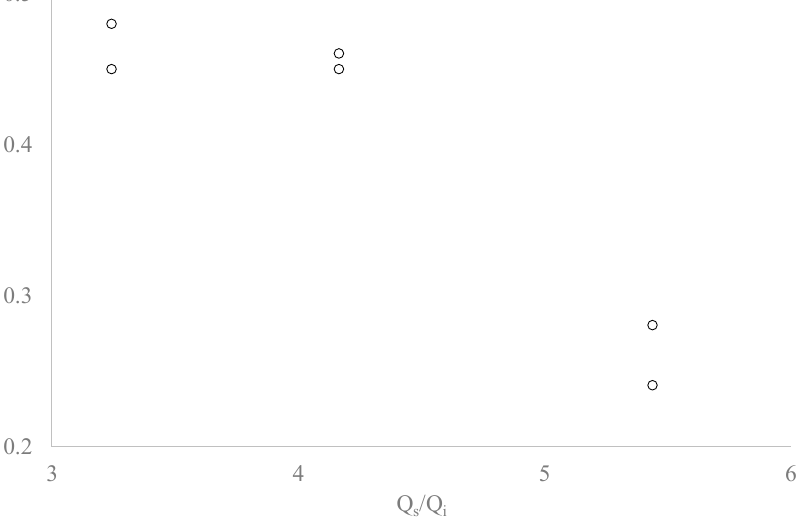
Q ). Figure 13. Relationship between e and the ratio of the fluid ( Q i ) and sediment ( Q s s